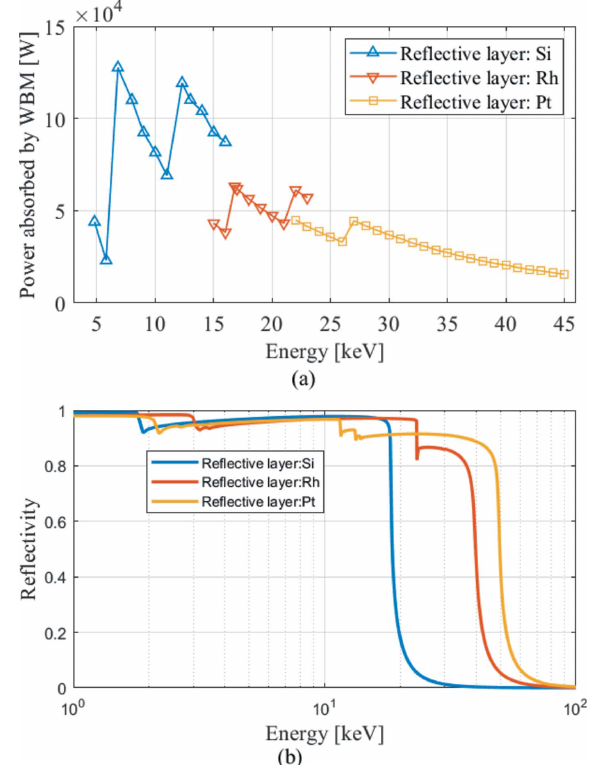
Figure 2 ( a ) Power absorbed by the WBM at different photon energies. The range of the fundamental harmonic is from 4.8 keV to 6.8 keV, the range of the third harmonic is from 6.8 keV to 11 keV, the range of the fifth harmonic is from 12.3 keV to 26 keV, and the range of the seventh harmonic is from 27 keV to 45 keV. ( b ) Reflectivity curve of the Si, Rh and Pt